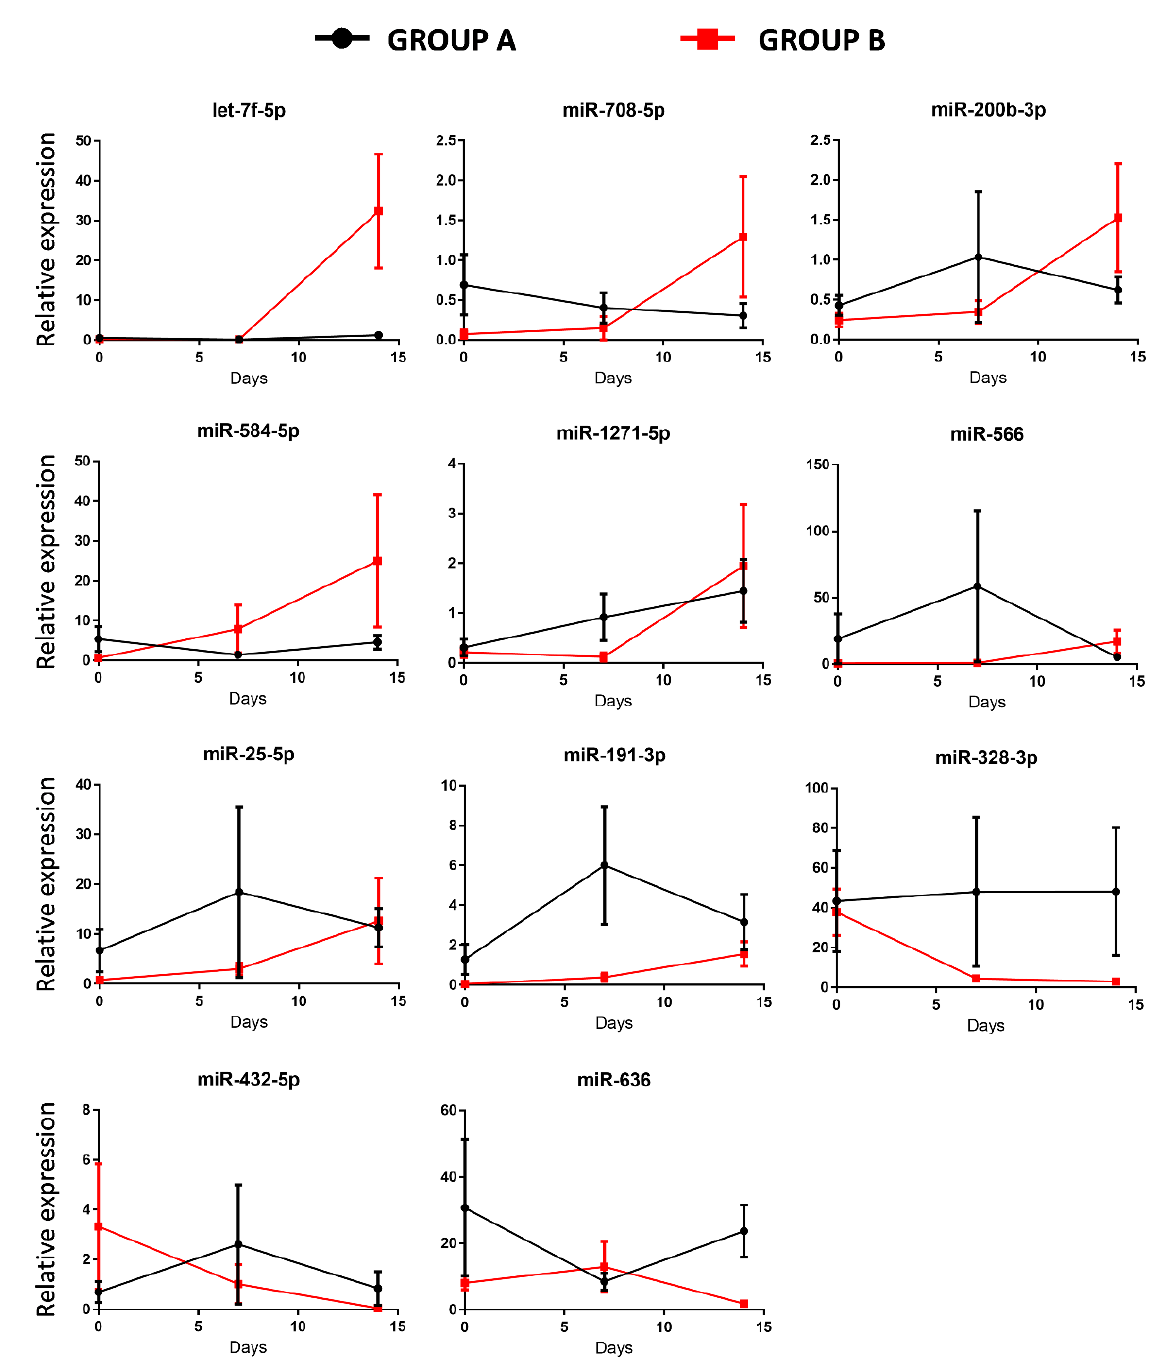
Figure 5. Temporal expression of miRNAs after 7 and 14 days of ECMO support in group A and in group B patients. Data shown are mean values ± SE of miRNA expression of 10 patients for each time point.